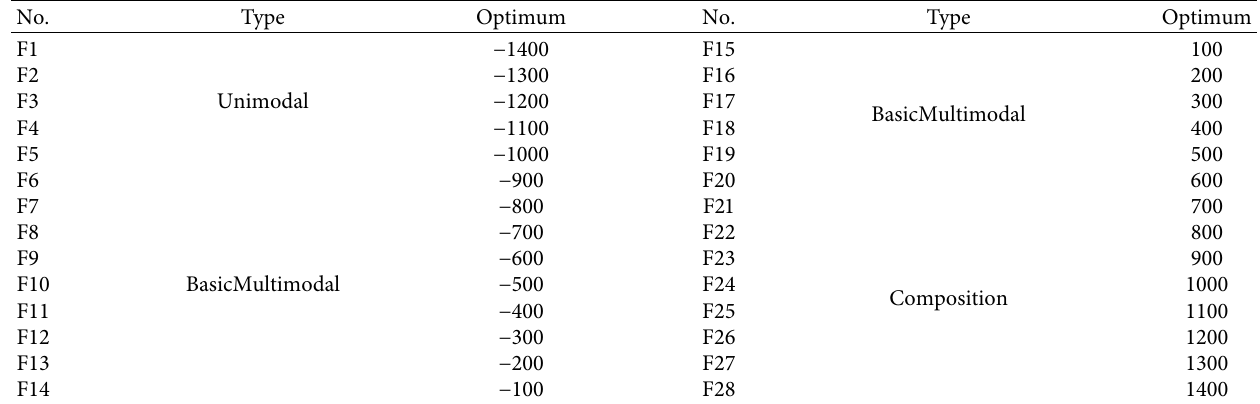
Table 1: Benchmark functions of CEC2013 (Test APPE’s performance).